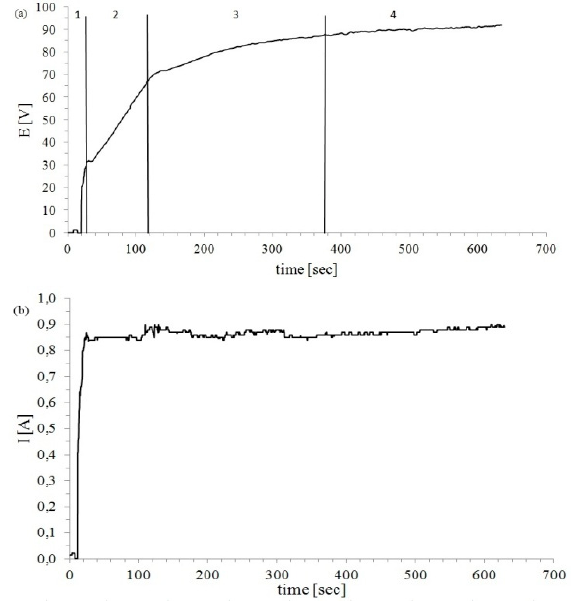
Figure 1. Electric parameters behavior plots ( a ) voltage as a function of treatment time; ( b ) current as a function of treatment time.